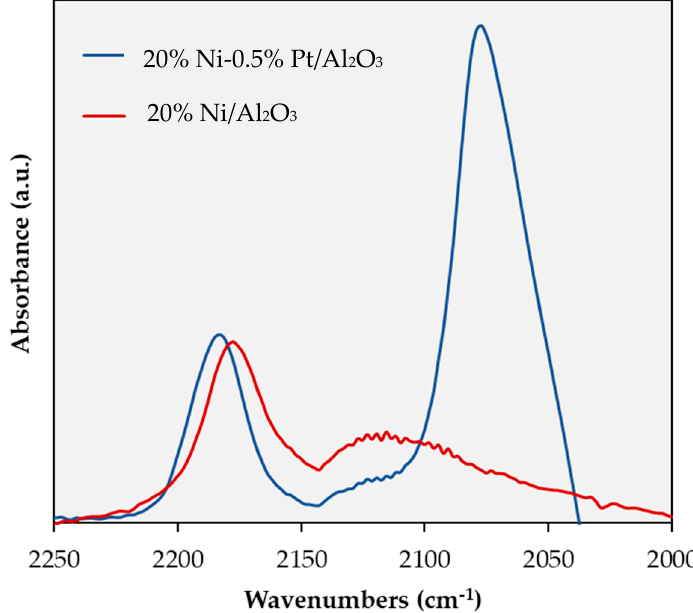
Figure 5. In situ DRIFTS spectra of 20% Ni/Al 2 O 3 (a) and 20% Ni-0.5% Pt/Al 2 O 3 (b) after CO adsorption.